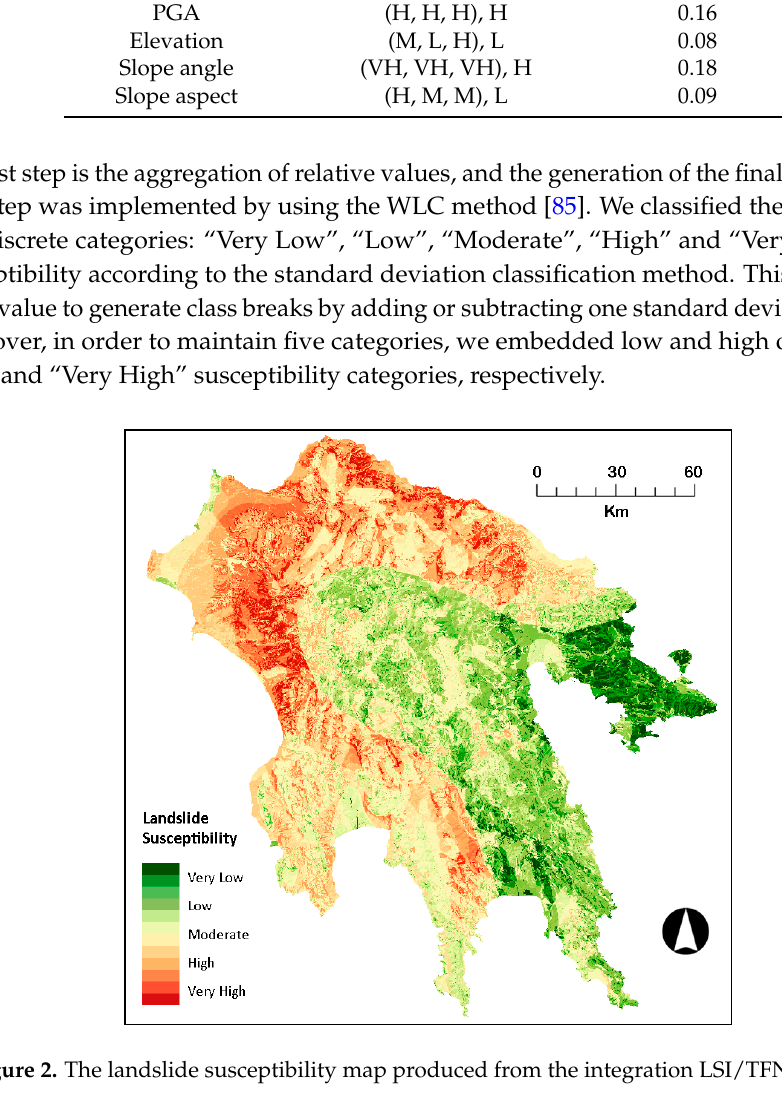
Table 2. Weight values for each factor according to the integration LSI/TFNW method.